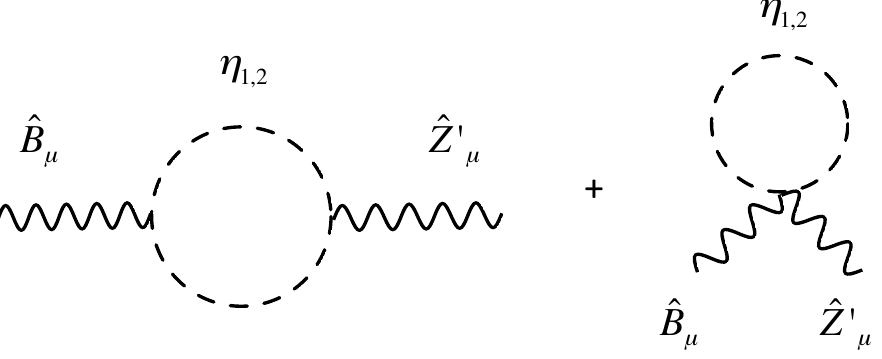
Figure 4 . One-loop diagrams inducing kinetic mixing between U(1) Y and U(1) X gauge